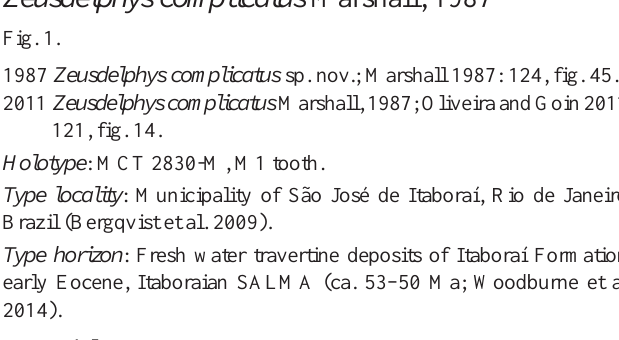
1987 Zeusdelphys complicatus sp. nov.; Marshall 1987: 124, fig. 45. 2011 Zeusdelphys complicatus Marshall, 1987; Oliveira and Goin 2011: 121, fig. 14. Holotype : MCT 2830-M, M1 tooth. Brazil (Bergqvist et al. 2009).